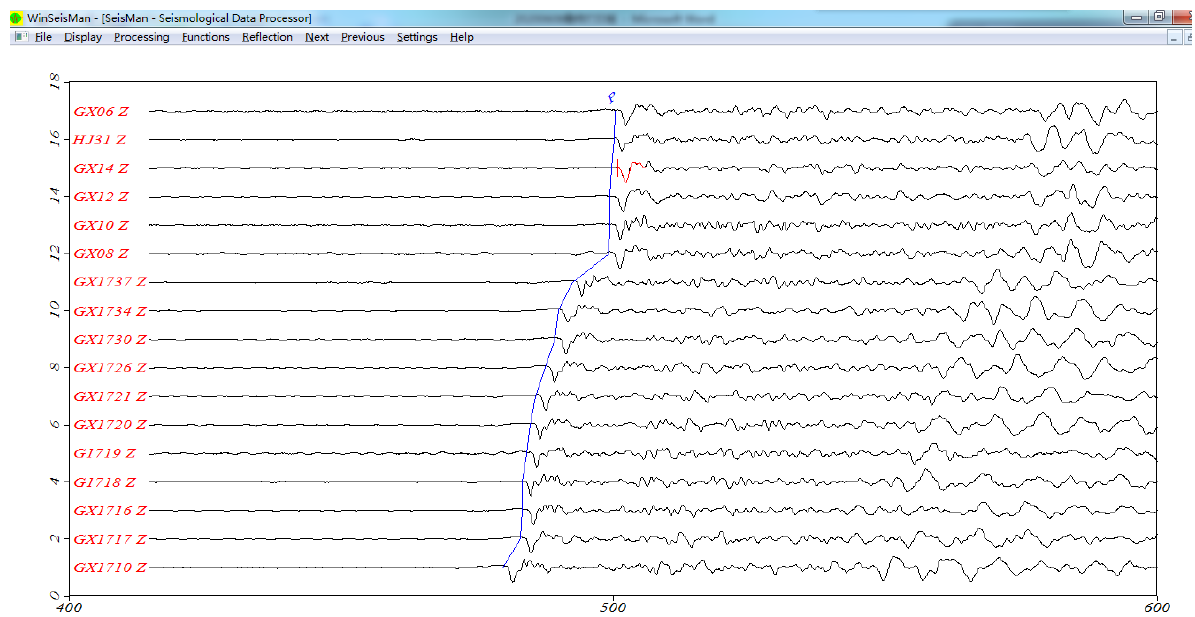
Figure 10. wavelet selection (band-pass filtered). Figure 10. Wavelet selection (band-pass